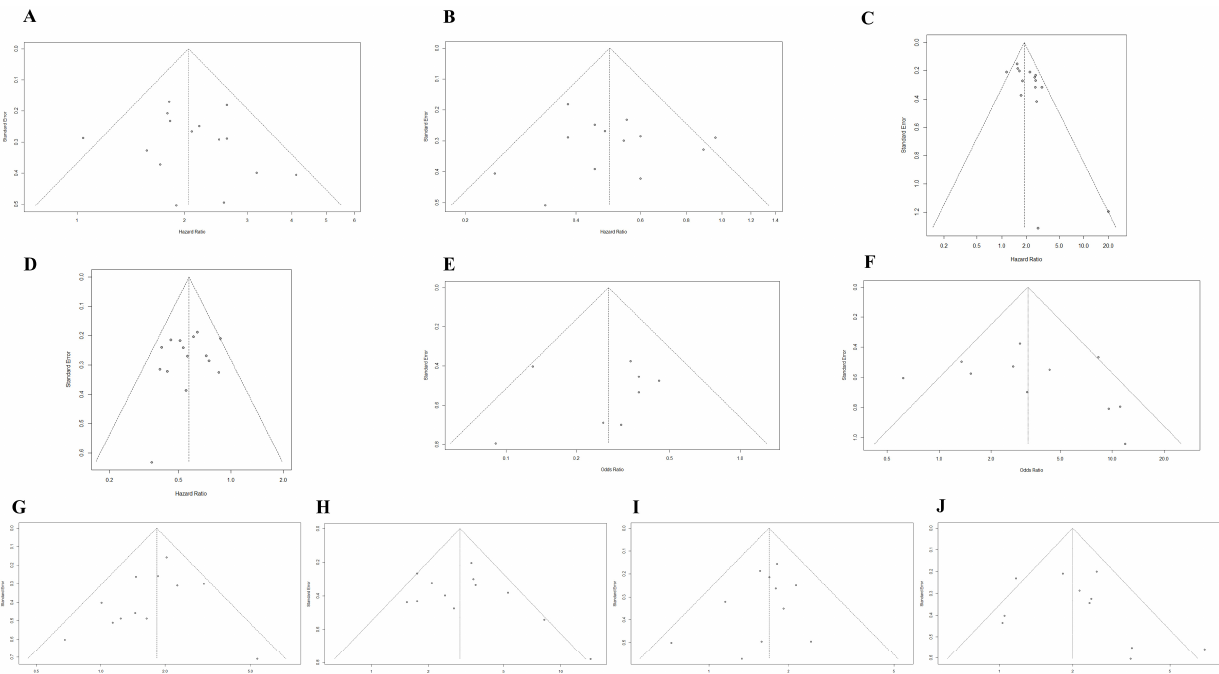
Figure 4. ( A ) Funnel plot for the association between upward trend in NLR after ICI treatment and OS. ( B ) Funnel plot for the association between downward trend in NLR after ICI treatment and OS. ( C ) Funnel plot for the association between upward trend in NLR after ICI treatment and PFS. ( D ) Funnel plot for the association between downward trend in NLR after ICI treatment and PFS. ( E ) Funnel plot for the association between upward trend in NLR after ICI treatment and ORR. ( F ) Funnel plot for the association between downward trend in NLR after ICI treatment and ORR. ( G ) Funnel plot for the association between high level of baseline NLR and OS. ( H ) Funnel plot for the association between high level of post-treatment NLR and OS. ( I ) Funnel plot for the association between high level of baseline NLR and PFS. ( J ) Funnel plot for the association between high level of post-treatment NLR and